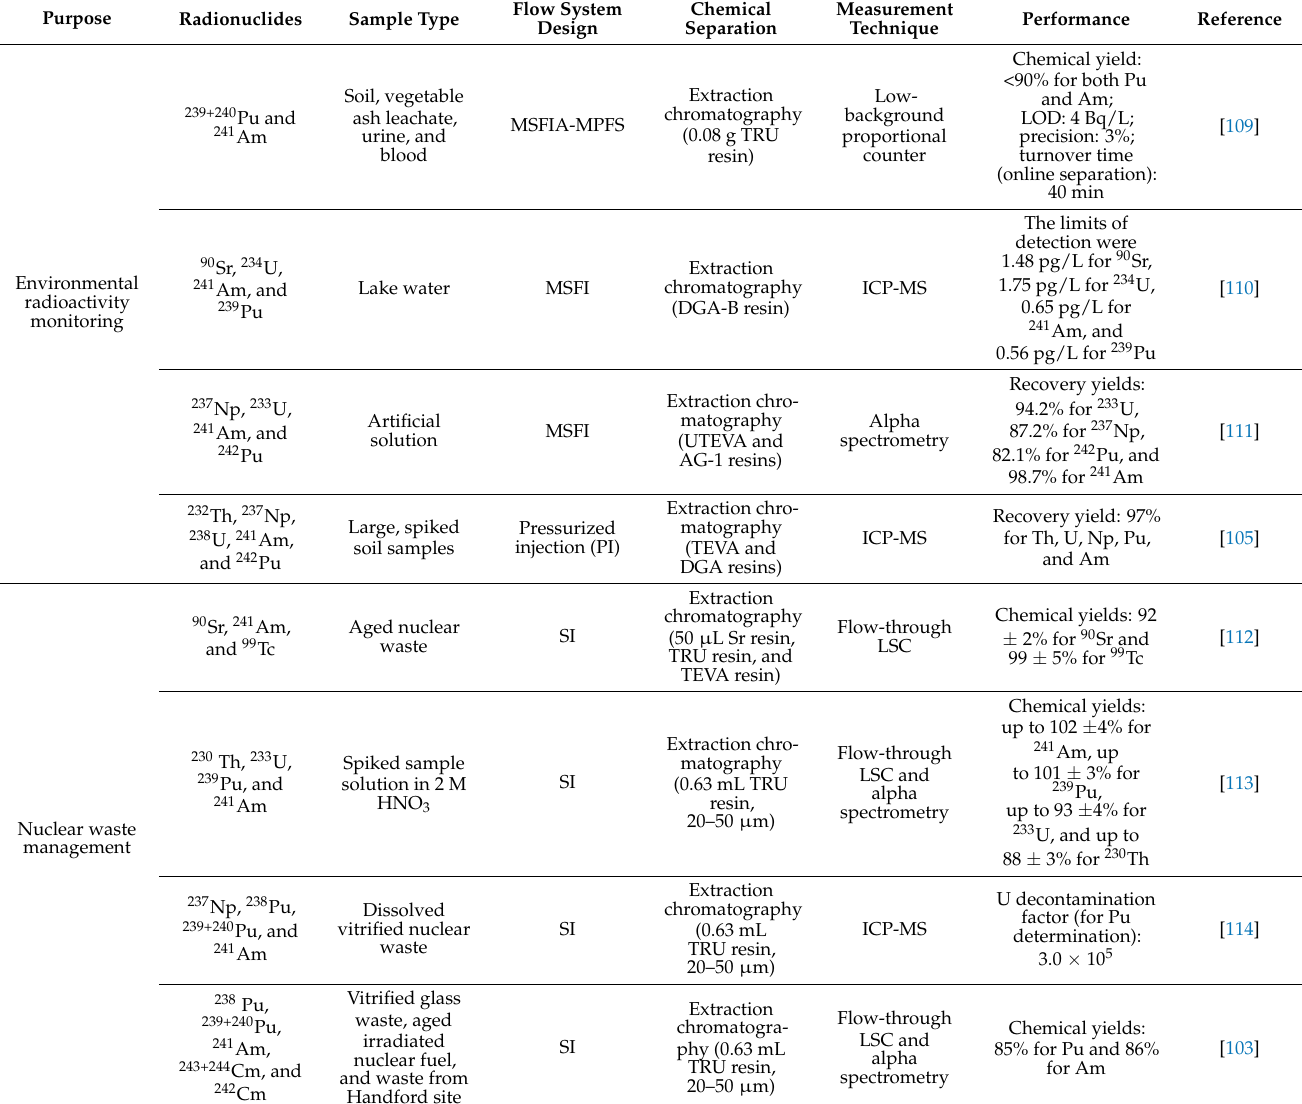
Table 7. Overview of flow approaches developed for 241 Am